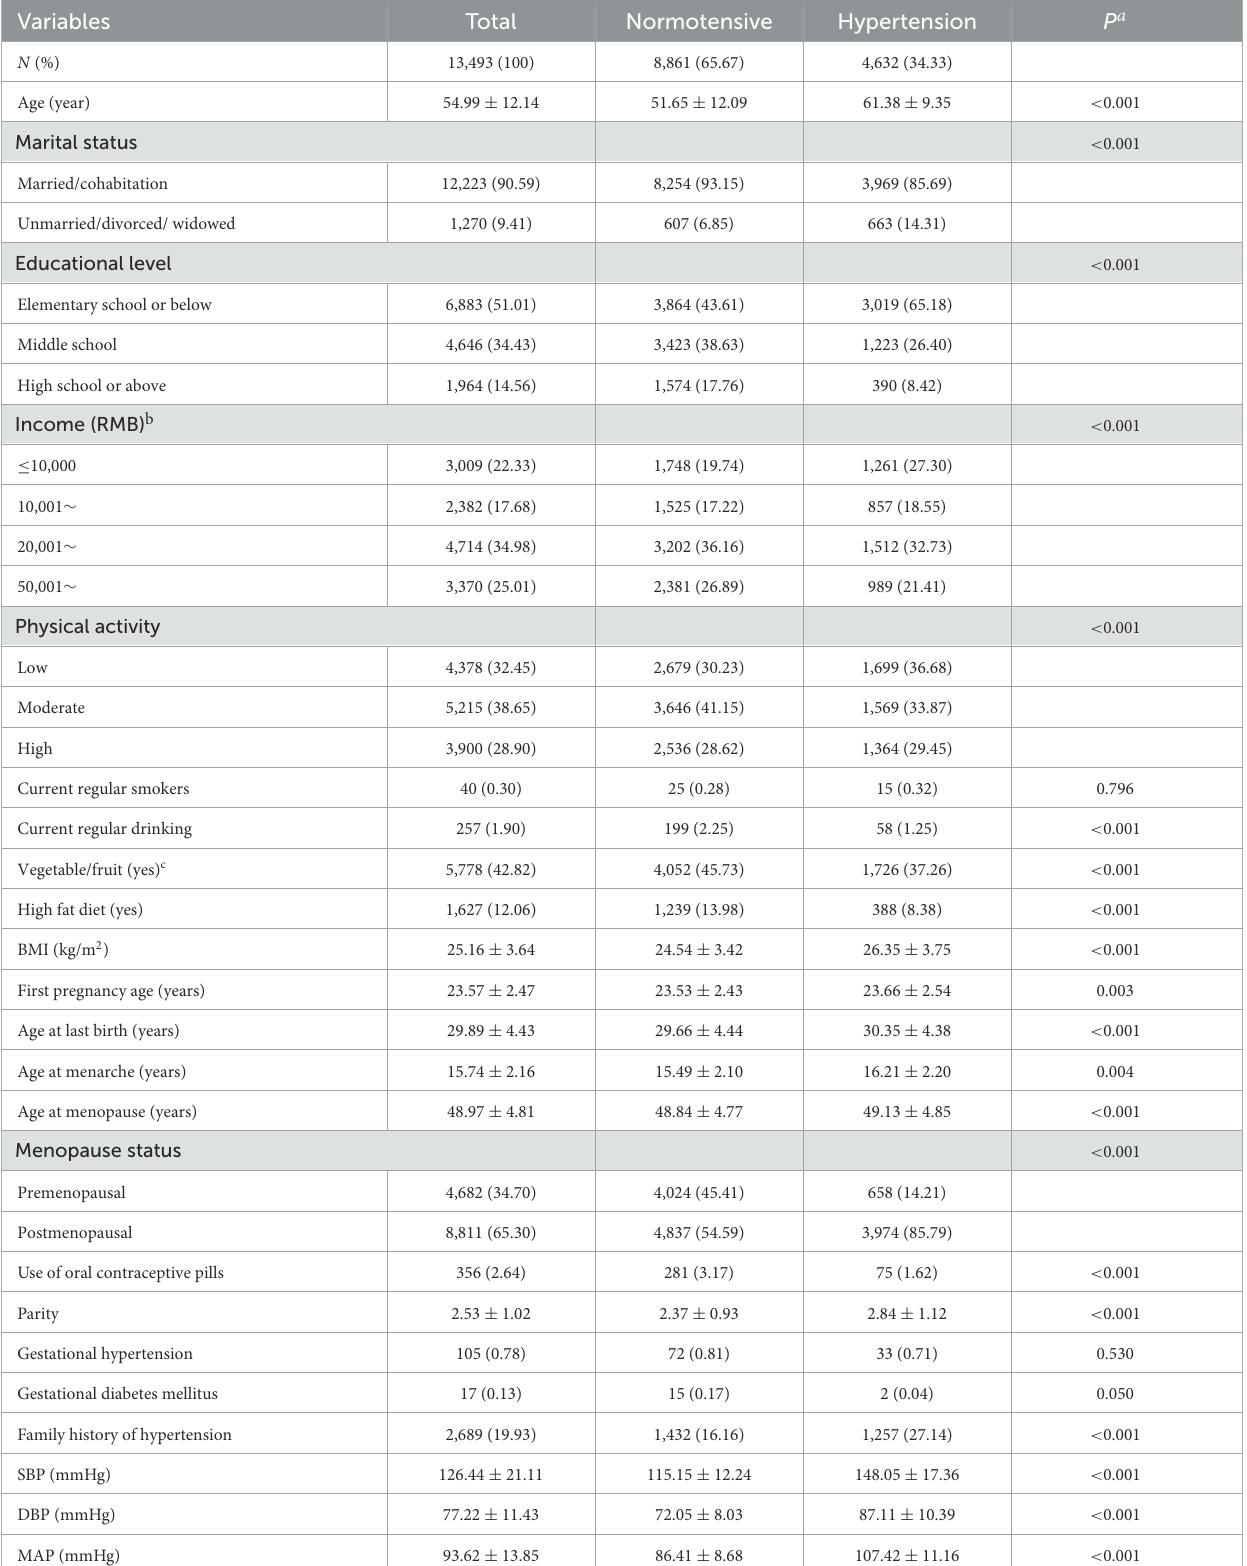
TABLE 1 Demographic characteristics of participants according to hypertension